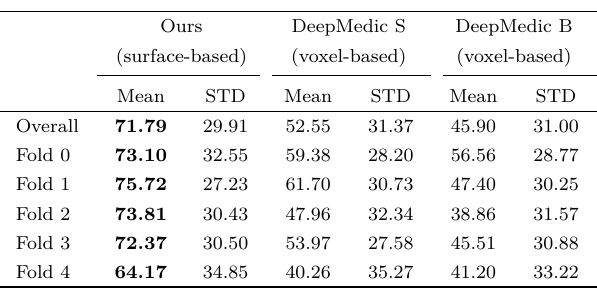
Table 4 Comparison of segmentation results on DSCs. U-Net failed to provide segmentation results